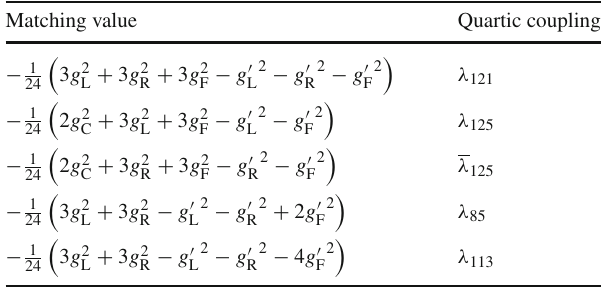
Table 12 Scalar quartic couplings matching conditions with five or six D-term interactions. The λ i couplings refer to the ( L → R ) part of V 4 Matching value Quartic coupling